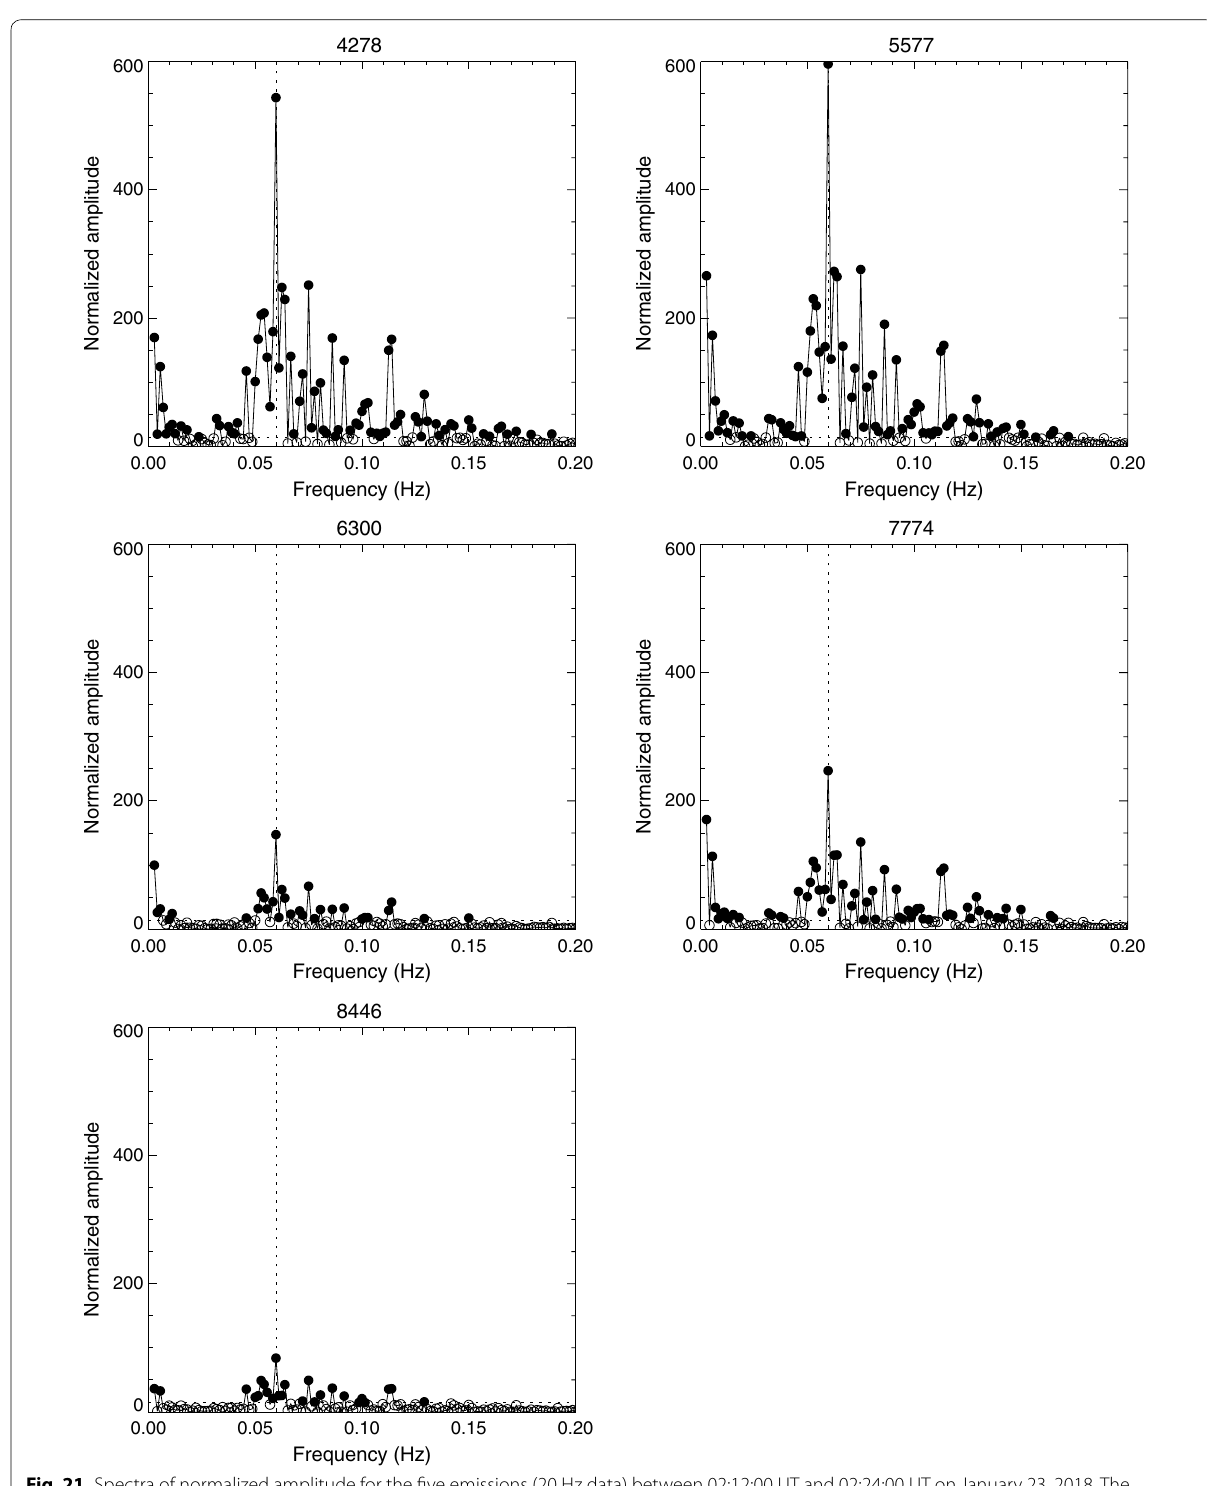
Fig. 21 Spectra of normalized amplitude for the five emissions (20 Hz data) between 02:12:00 UT and 02:24:00 UT on January 23, 2018. The horizontal dashed lines denote the 99% significance level. The vertical dotted lines denote oscillations of 1/16.74 Hz (i.e., period being 16.74